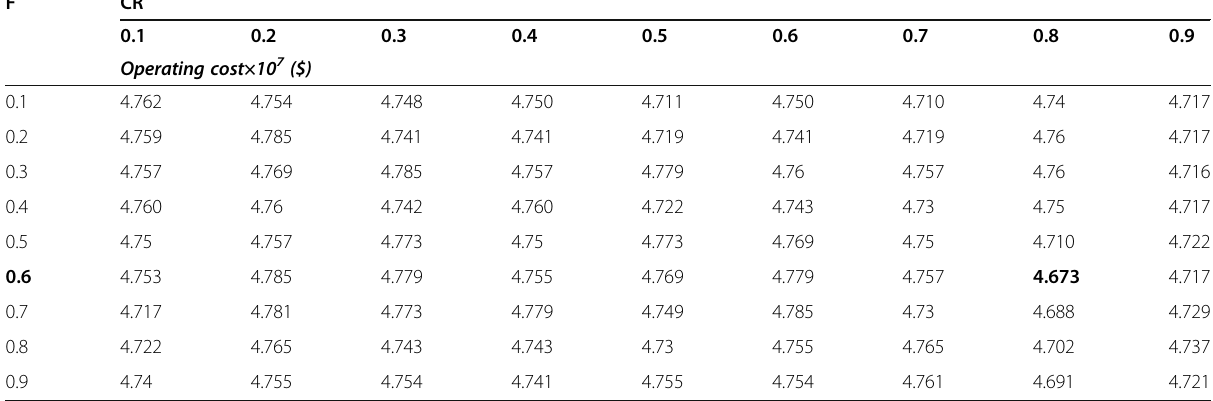
Table 12 Control of F and CR on DECSA for the Indian 191-bus practical system F